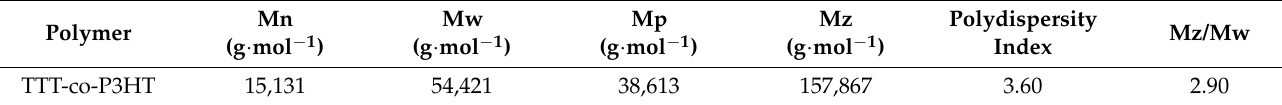
Table 1. Size exclusion chromatography analysis of